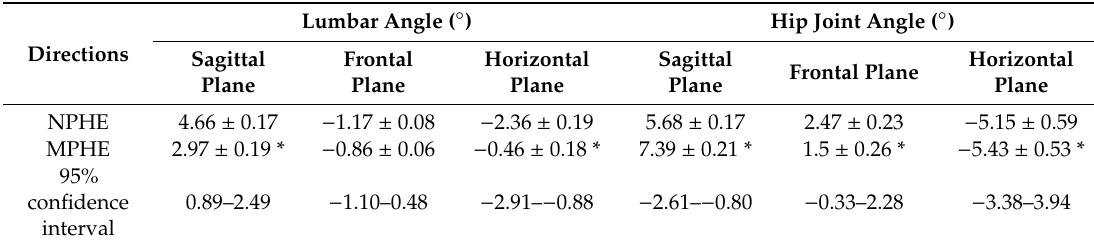
Table 1. Lumbar and hip joint angles at 10 ◦ tilt during PHE.